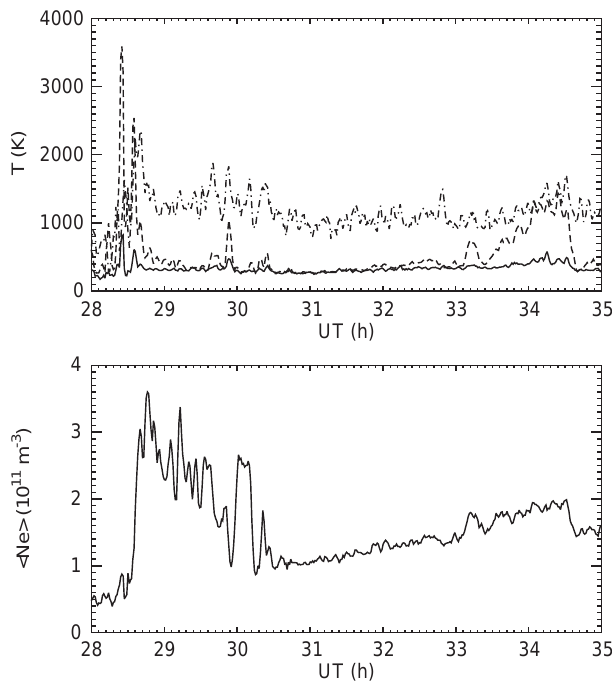
Fig. 4. Top panel : time series of T (averaged between 106 and i k 116 km, full line ), T e (averages between 106 and 116 km, dashed line ) and T (averaged between 140 and 160 km, dash-dot line ). Bottom i k panel : time series of the electron density averaged between 106